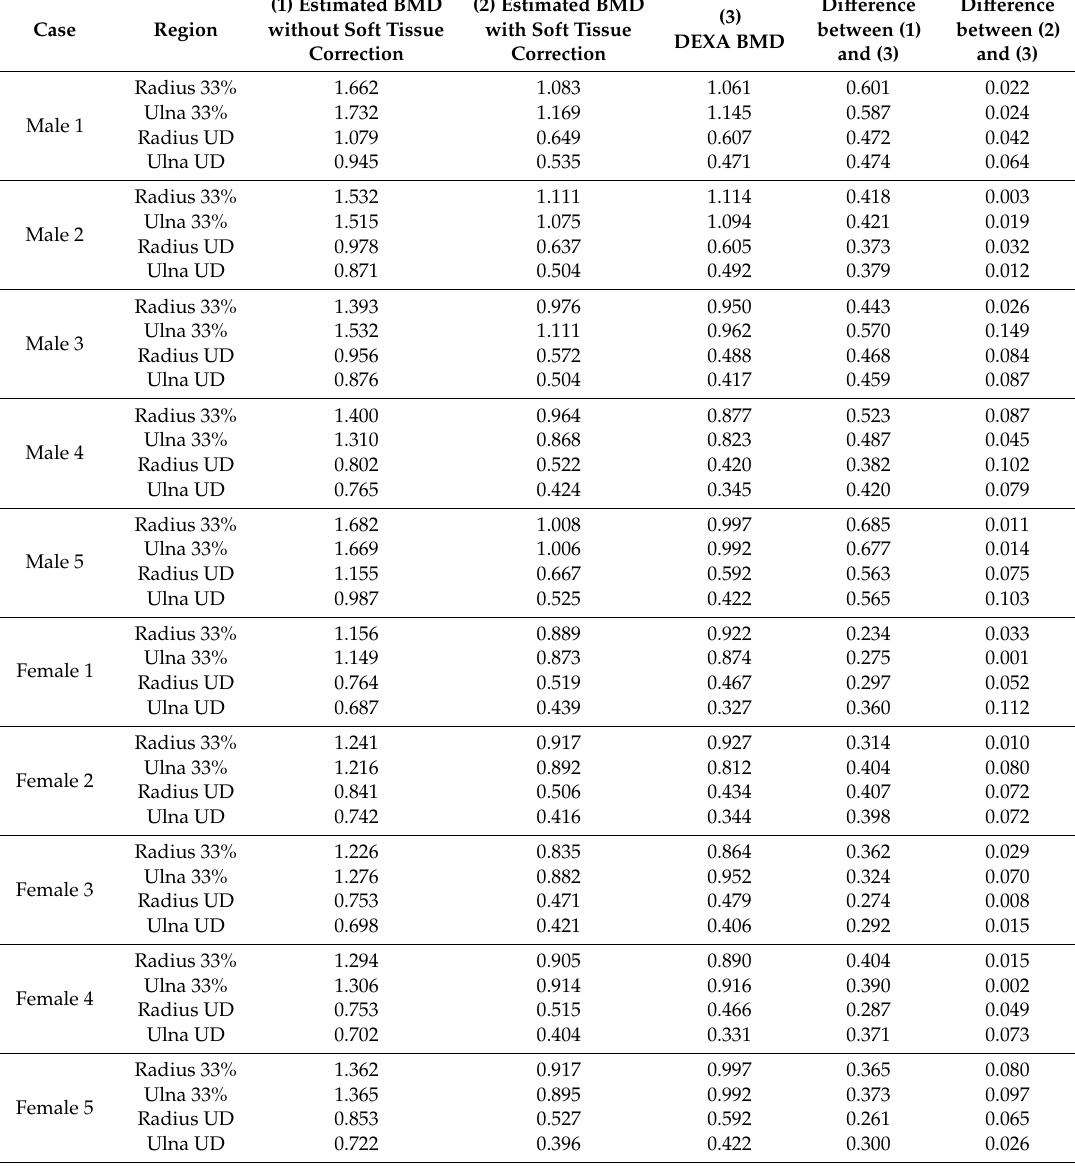
Table 5. Comparison between estimated BMDs and DEXA BMDs (in g / cm 2